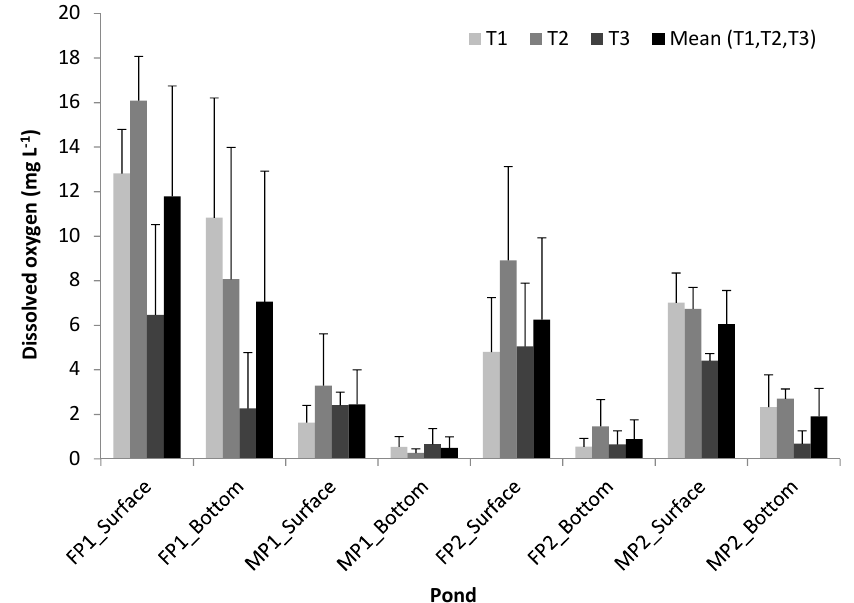
Figure 3. Variability of dissolved oxygen in the ponds. T1, T2 and T3 represent the mean value of dissolved oxygen of each sampling time; and mean (T1, T2, T3) represents the mean value of dissolved oxygen of the three sampling times. Error bars represent the standard deviation. Water 2020 , 12 , x FOR PEER REVIEW